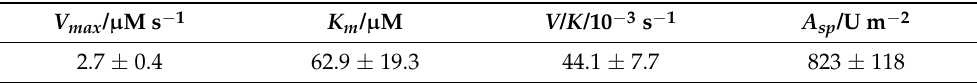
Table 3. Kinetic parameters of optimized PVDF- g -EL ( n =